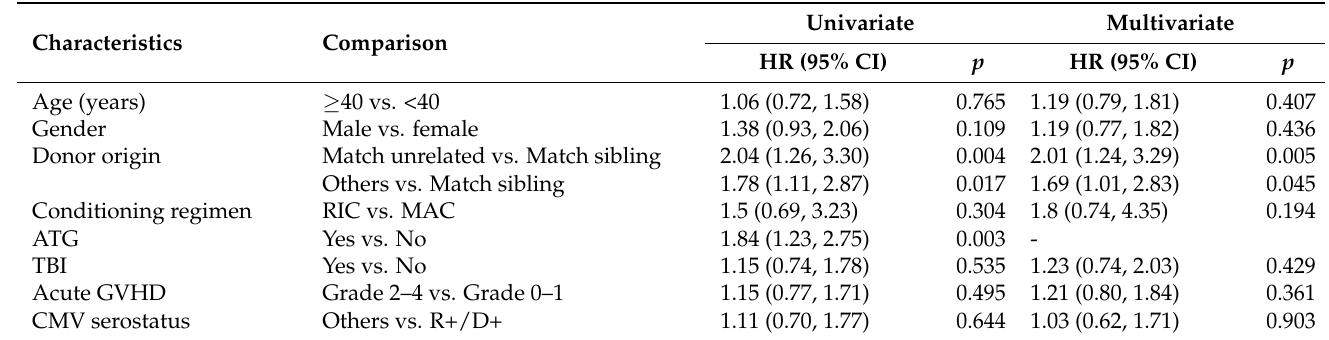
Table 3. Cox proportional hazard regression analysis for CMV reactivation within 100 days after transplantation.